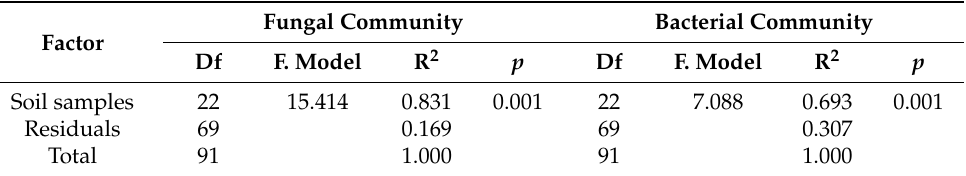
Figure 4. PCA of the microbial communities for fungal communities ( a ) and bacterial communities ( b ) in all soil samples. Table 2. Permutational multivariate analysis of variance (PERMANOVA) results for both fungal and bacterial communities associated with morel cultivation soil. Permutations = 999. Significant p -values at p ≤ 0.05 are highlighted in bold.